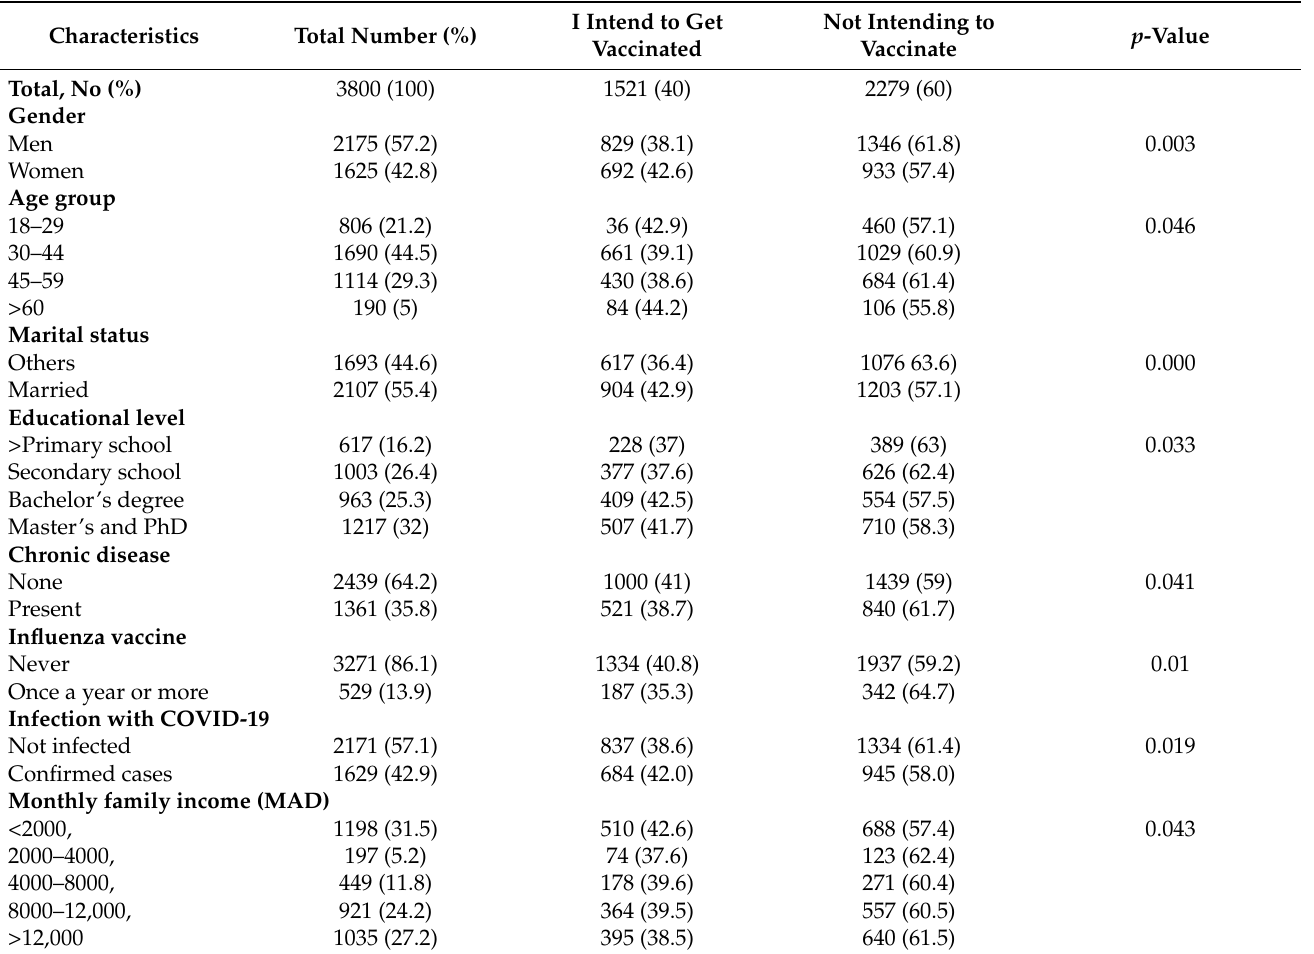
Table 1. Frequency of intention to receive COVID-19 vaccine by sociodemographic